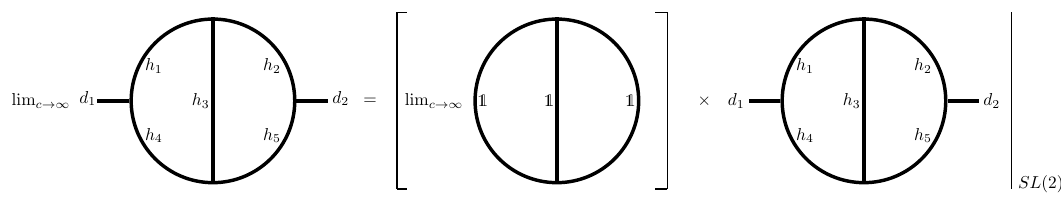
Figure 3. The large- c factorization of a genus-2 two-point block in the plumbing frame, in which the punctured Riemann surface is built by plumbing together two-holed (or punctured) discs using SL(2)